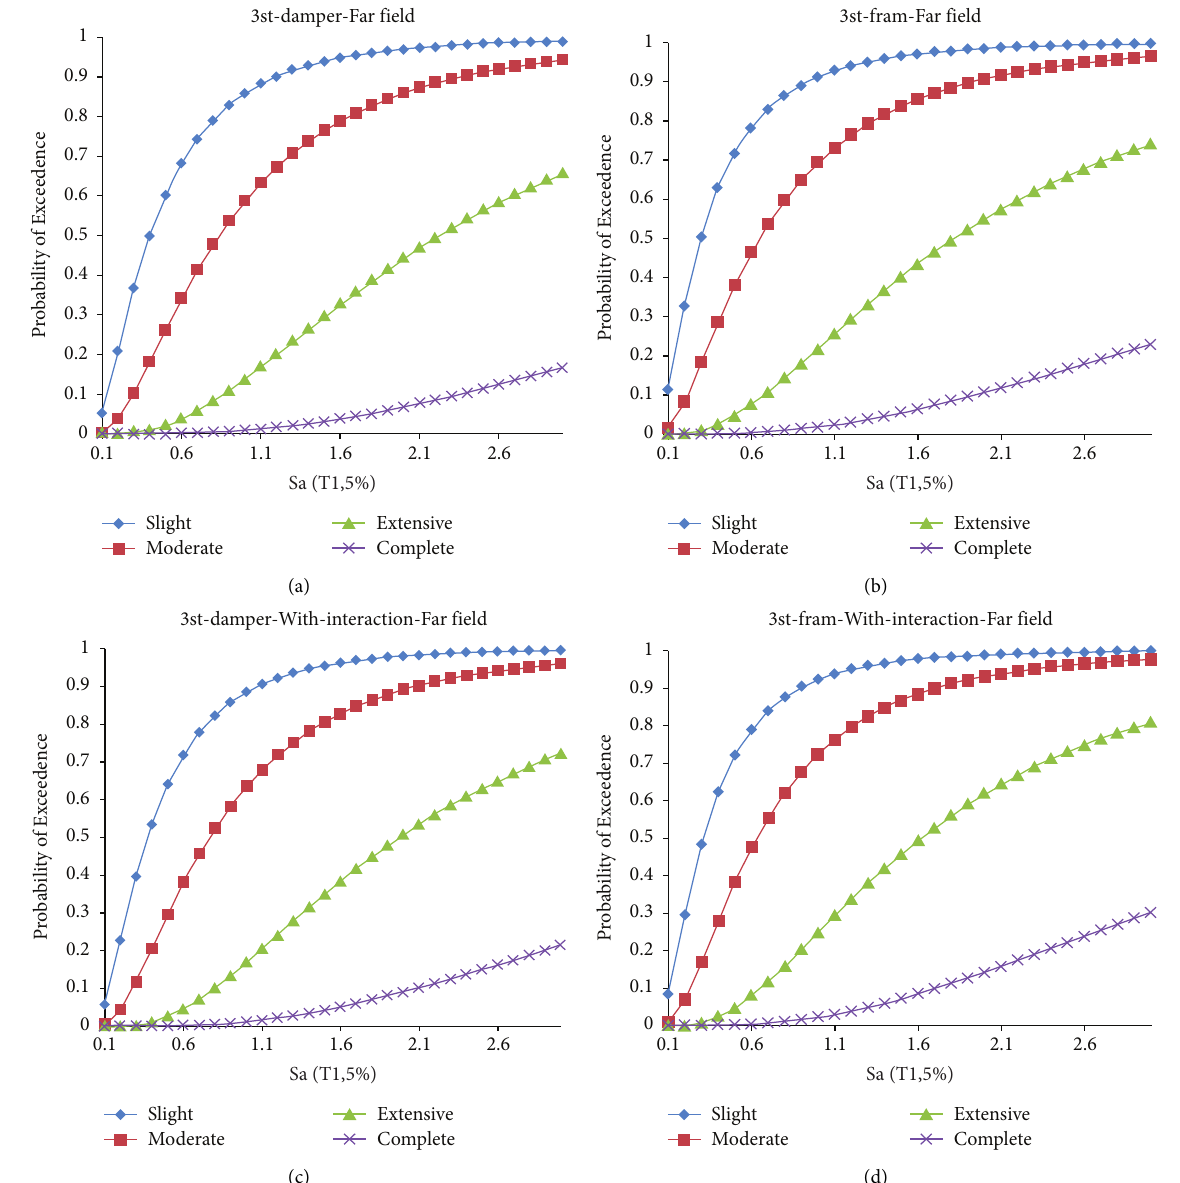
Figure 8: Fragility curves in 3-story ordinary moment resisting frame affected by far-field earthquakes. Examined cases: (a) with damper without considering SSI; (b) without Damper and SSI effect; (c) with damper and considering SSI; (d) without damper but considering SSI